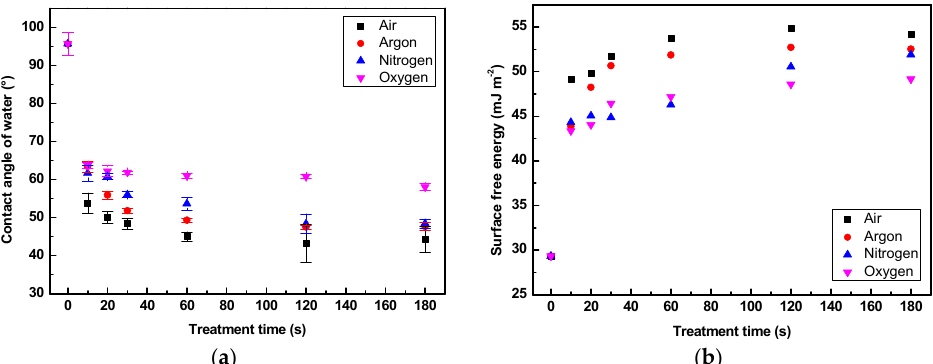
Figure 3. Surface wettability of LDPE as a function of plasma treatment time for LDPE treated using different gases: ( a ) contact angle of water; ( b ) surface free energy (SFE).